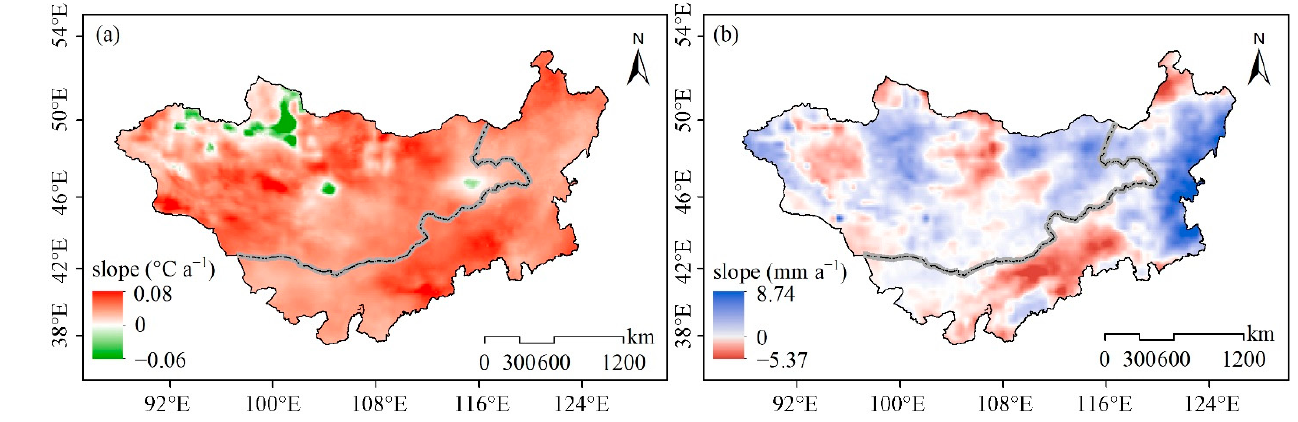
Figure 9. Spatial variation in temperature ( a ) and precipitation ( b ) in the Mongolian Plateau.